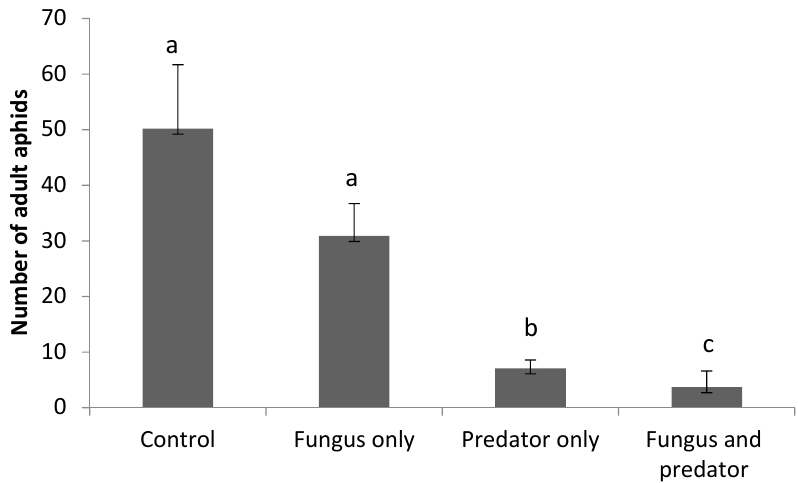
Figure 4. Comparison of the numbers ( ± SE) of living R. padi adults at the end of the study between treatments treated or untreated with A. aphidimyza ( n = 40) and M. brunneum . Letters above columns indicate significant ( p < 0.05) differences among treatments.